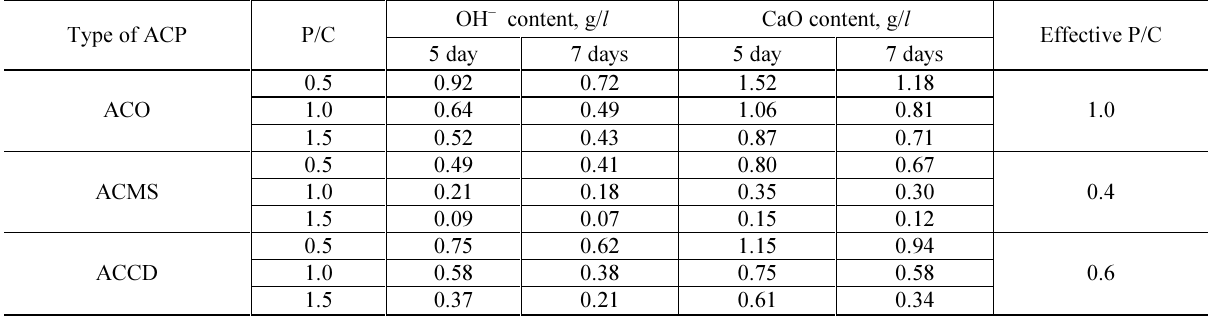
– Table 2. OH and available CaO content in liquid phase of hydrating ACP Type of